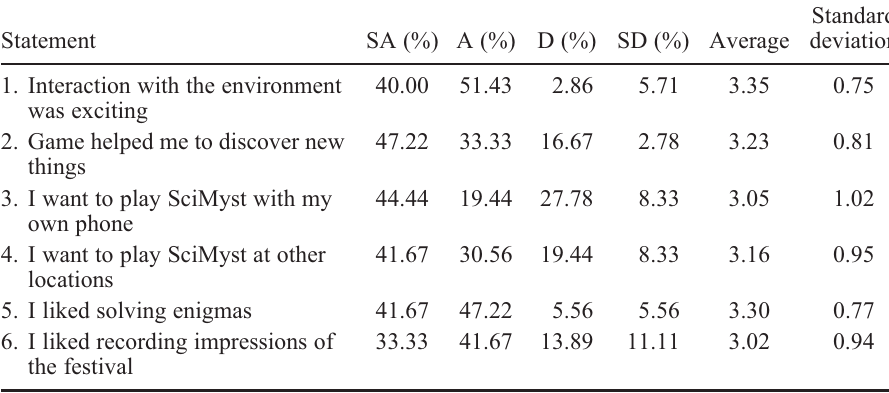
Table 2. Results of the mobile questionnaire for